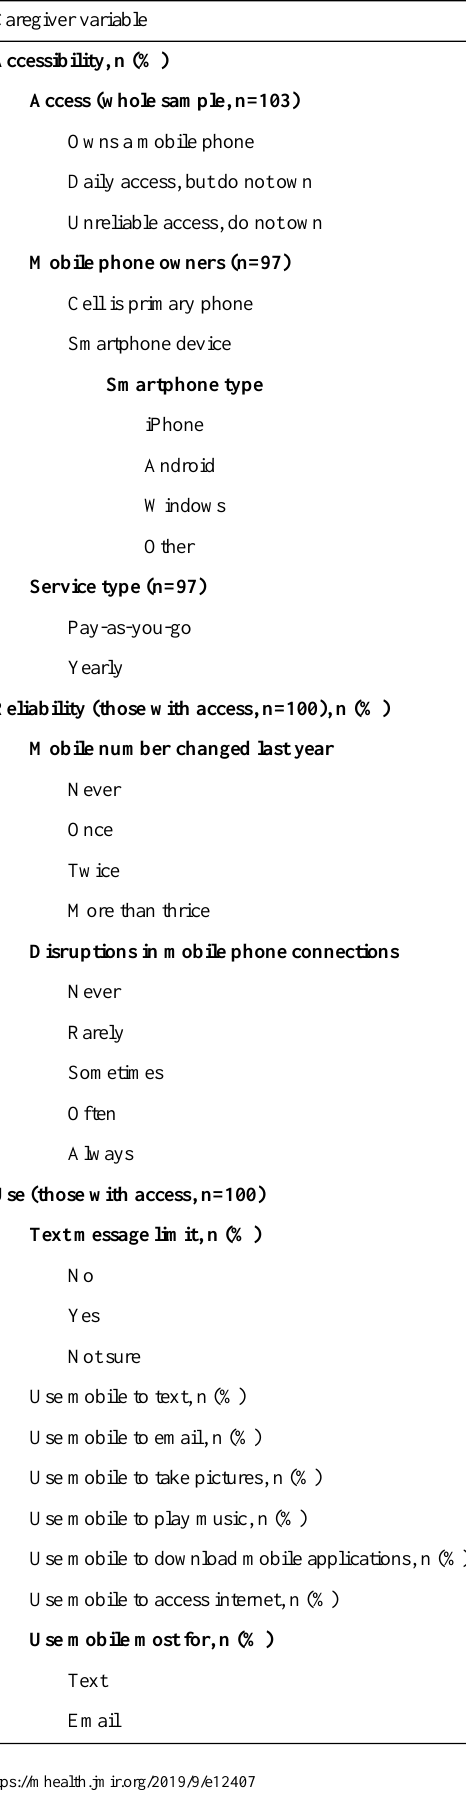
Table 2. Mobile phone accessibility, reliability, and